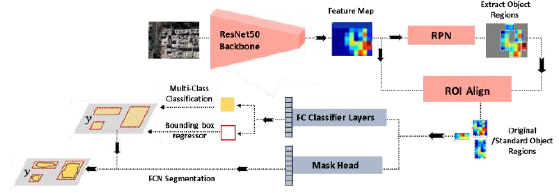
Figure 12. Architecture of Mask-RCNN